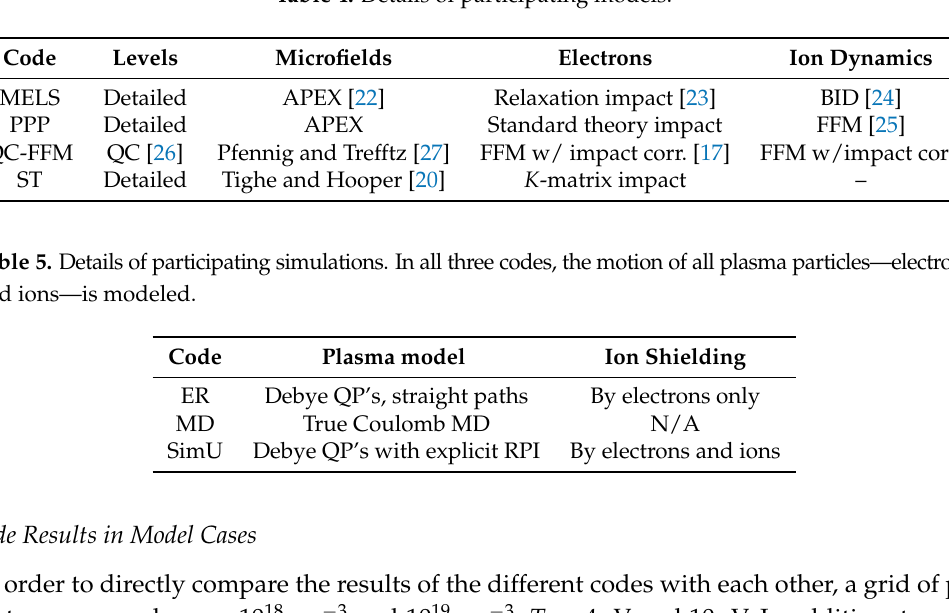
Table 4. Details of participating models.